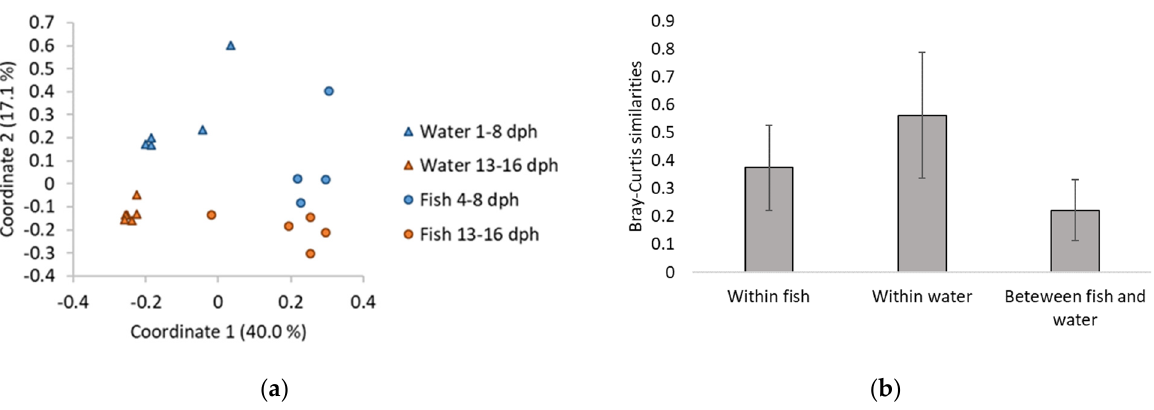
Figure 2. ( a ) PCoA ordination plot based on Bray-Curtis similarities for comparison of water and fish microbiota from samples taken early (1/4–8 dph) and late (13–16 dph) in the experiment. One fish sample consists of five pooled cod larvae from one rearing bottle. ( b ) Bray-Curtis similarities within fish and water microbiota, and between fish and water microbiota. Bars indicate standard deviation.